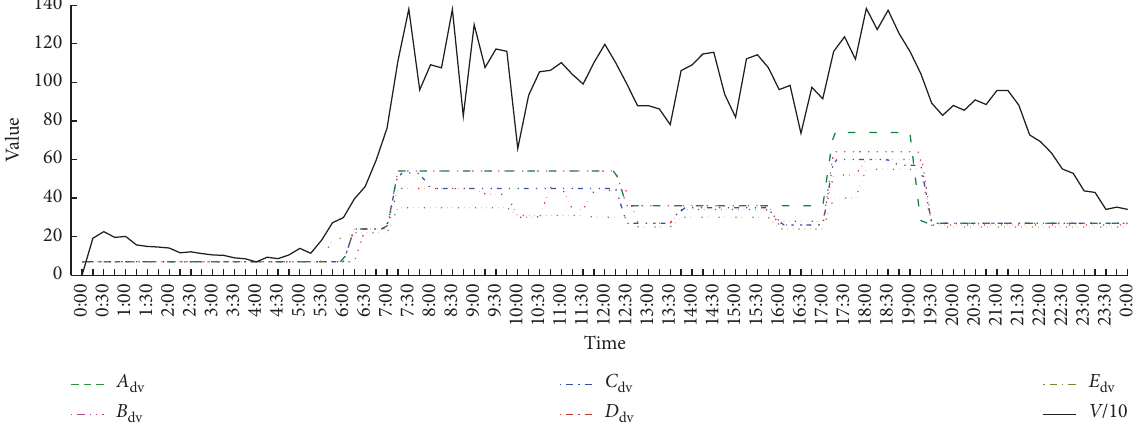
Figure 12: Change curve of the average vehicle delay at the Jiuhua road and Zheshan road intersection in each time periods of one day.